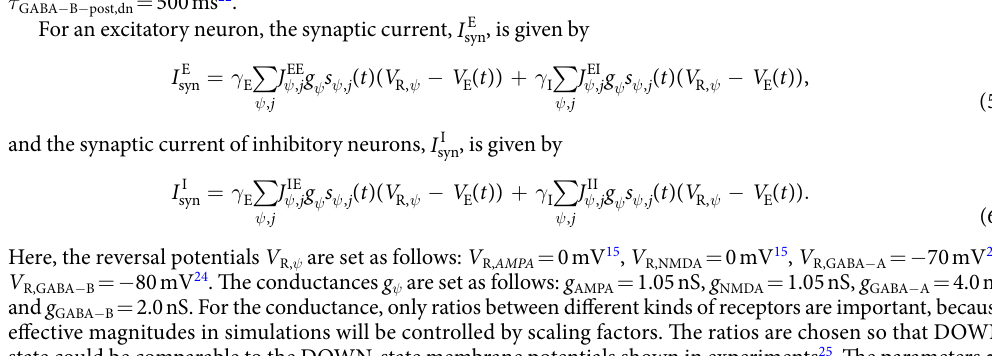
ψ ψ ψ where τ axon = 1 ms is the axonal delay of pre-synaptic neuron. Rising time constants are set as τ AMPA,up = 0.5 ms 19 , = 5.8 ms 20 , τ = 1.8 ms 21 , τ = 1.8 ms 21 and τ = 100 ms 22 . Decay time τ NMDA,up GABA − A − fast,up GABA − A − slow,up GABA − B − post,up constants are τ AMPA,dn = 4.0 ms 19 , τ NMDA,dn = 87.5 ms 20 , τ GABA − A − fast,dn = 12.0 ms 21 , τ GABA − A − slow,dn = 47.0 ms 21 and = 500 ms 22 . τ GABA − B − post,dn